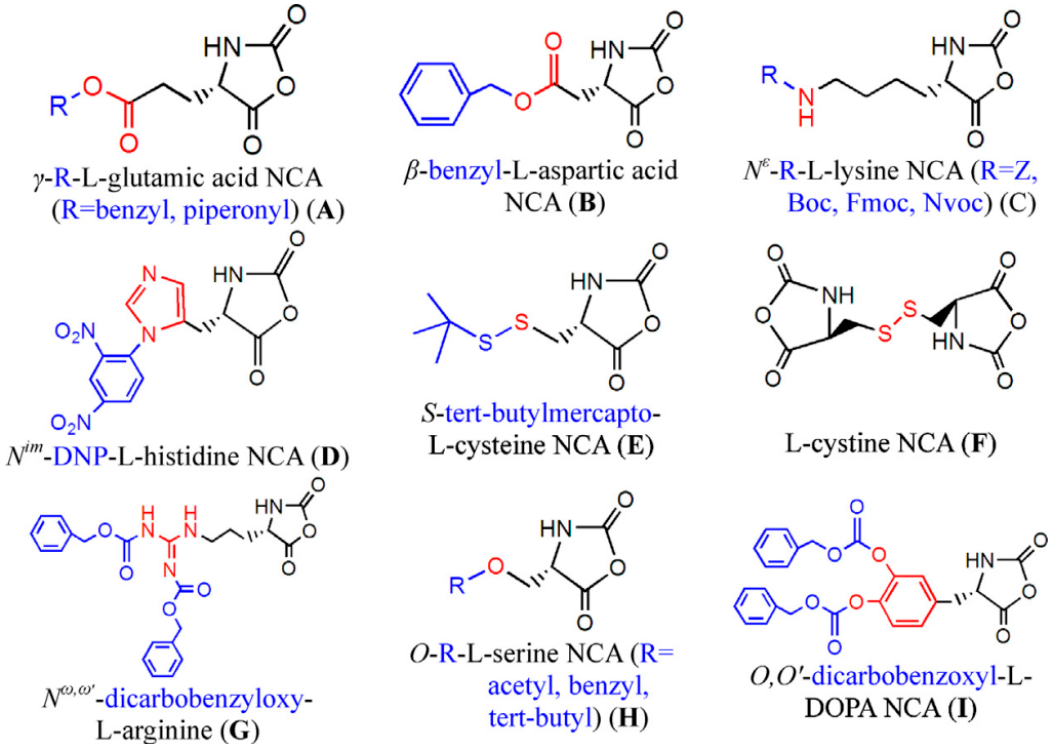
Figure 3. Functional NCA monomers containing a protected pendant functional group. Reproduced with permission from reference [31].